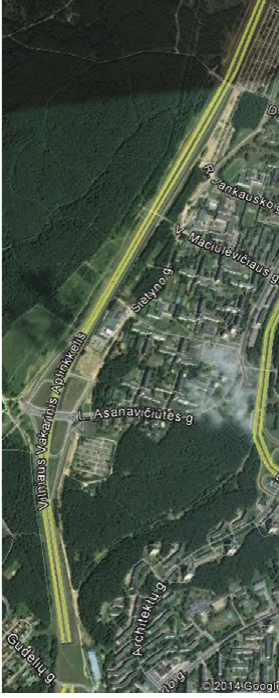
Fig. 1. Experimental area in Google Earth application – the section of Vilnius western bypass (Source: https://earth.google.com/